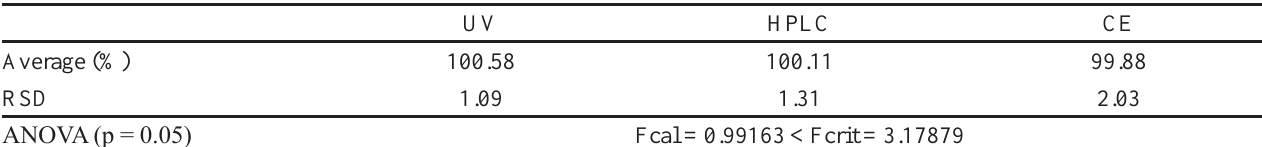
FIGURE 5 - MEKC electropherograms of RLX solutions submitted to forced degradation for 24 h (A) acidic hydrolysis (HCl 1.0 mol L -1 ), (B) basic hydrolysis (NaOH 1.0 mol L -1 ), (C) oxidative stress (H (E) heat stress (80°C). Electrophoretic conditions: BGE of boric acid 35.0 mmol L -1 + SDS 50.0 mmol L -1 pH 8.8, fused-silica capillary column (40.0 cm length x 50 µm i.d.), hydrodynamic injection time of 4 s at pressure 45 mBar, separation voltage 25 kV and column temperature 32 °C with detection at 280 nm.